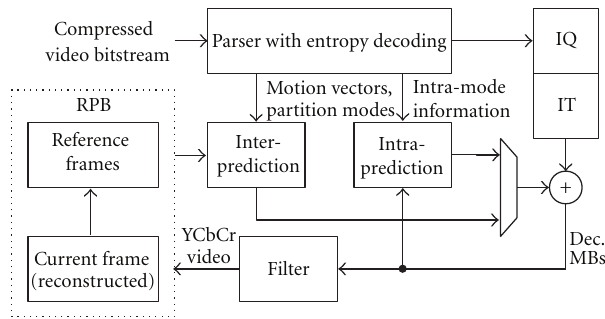
F 2: Block diagram of the H.264/AVC video